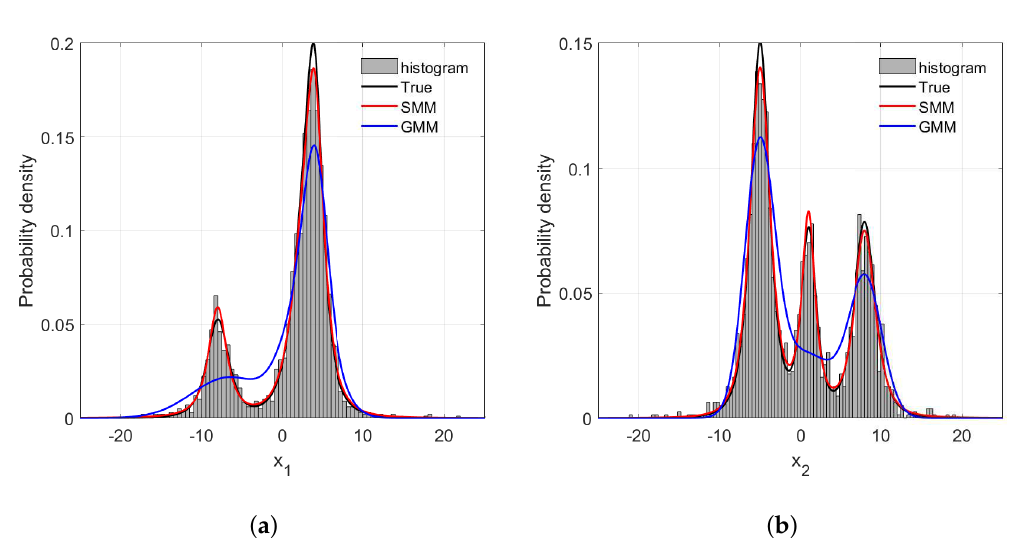
Figure 6. The frequency histogram and probability density curve with 3% rate outliers: ( a ) x 1 direction; ( b ) x 2